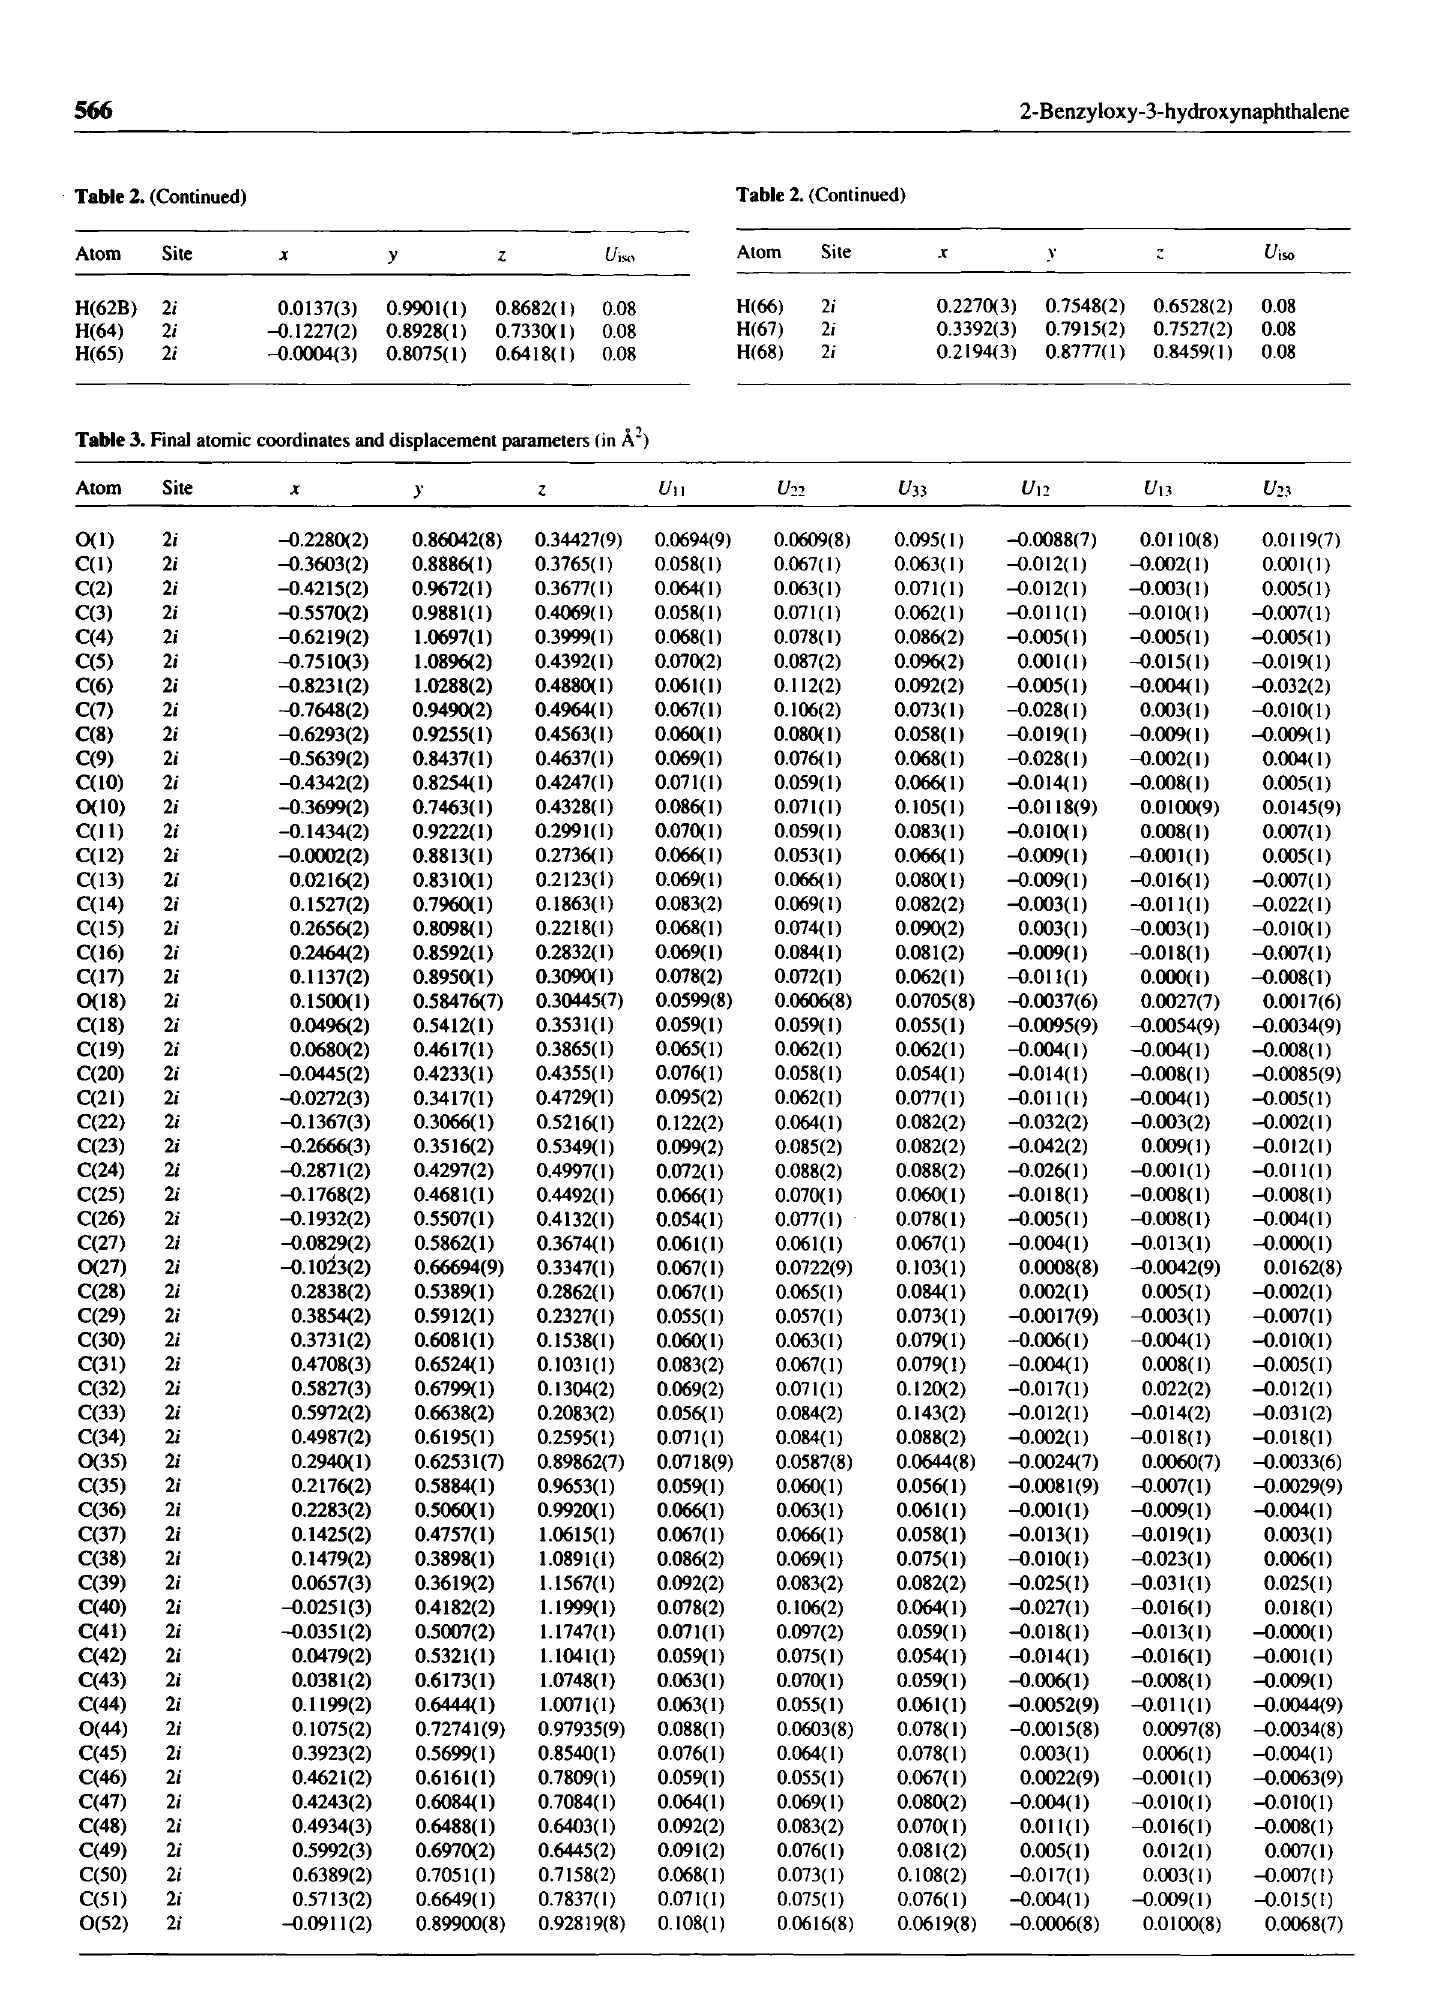
Table 3. Final atoinic coordinates and displacement parameters (in